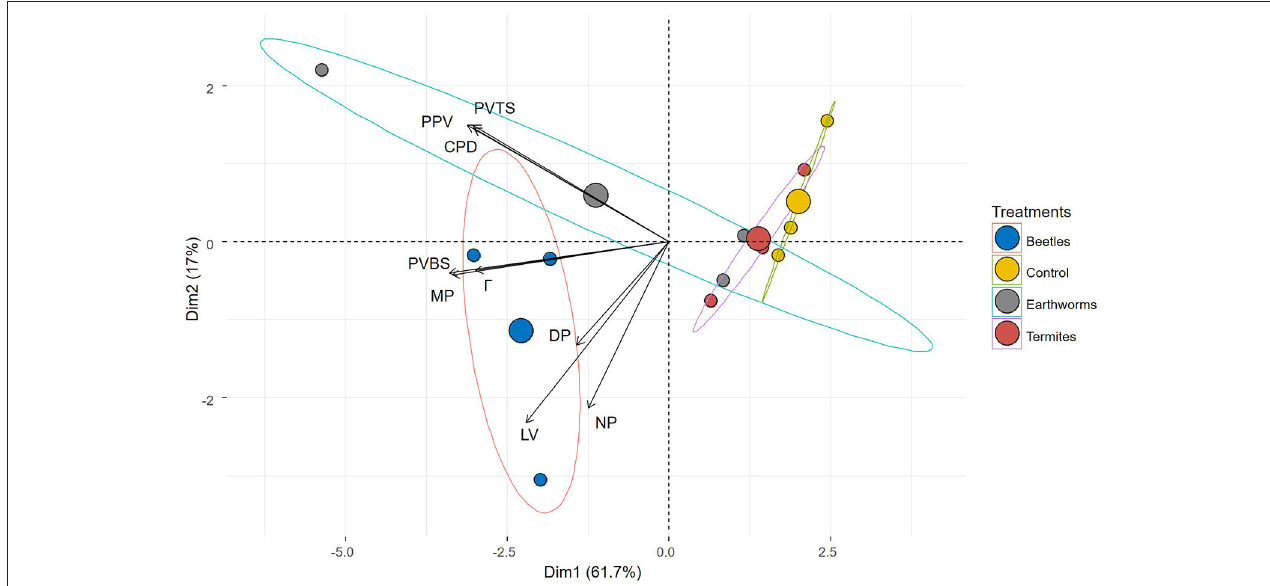
FIGURE 2 | Biplot showing the principal components analysis (PCA) from variables describing soil macroporosity for the different treatments (control in yellow, termite sheetings in red, dung beetles in blue and earthworm casts in gray) in the plane defined by axes 1 and 2 of the PCA. Variables are number of macropores (NP), macroporosity (%) (MP), pore diameter (mm) (DP), macropore volume connected to the surface (mm 3 ) (PVTS), macropore volume connected to the bottom surface (mm 3 ) (PVBS), percolating macropore volume (mm 3 ) (PPV), largest volume (mm 3 ) (LV), critical pore diameter (mm) (CPD), and connection probability ( Ŵ